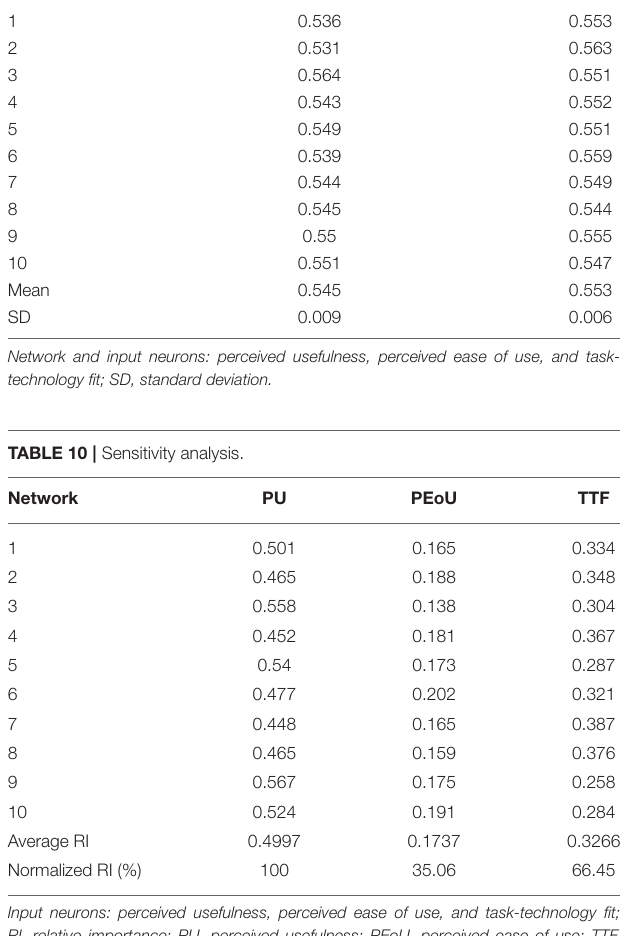
TABLE 9 | Root-mean-square error (RMSE) values for training and testing. Network